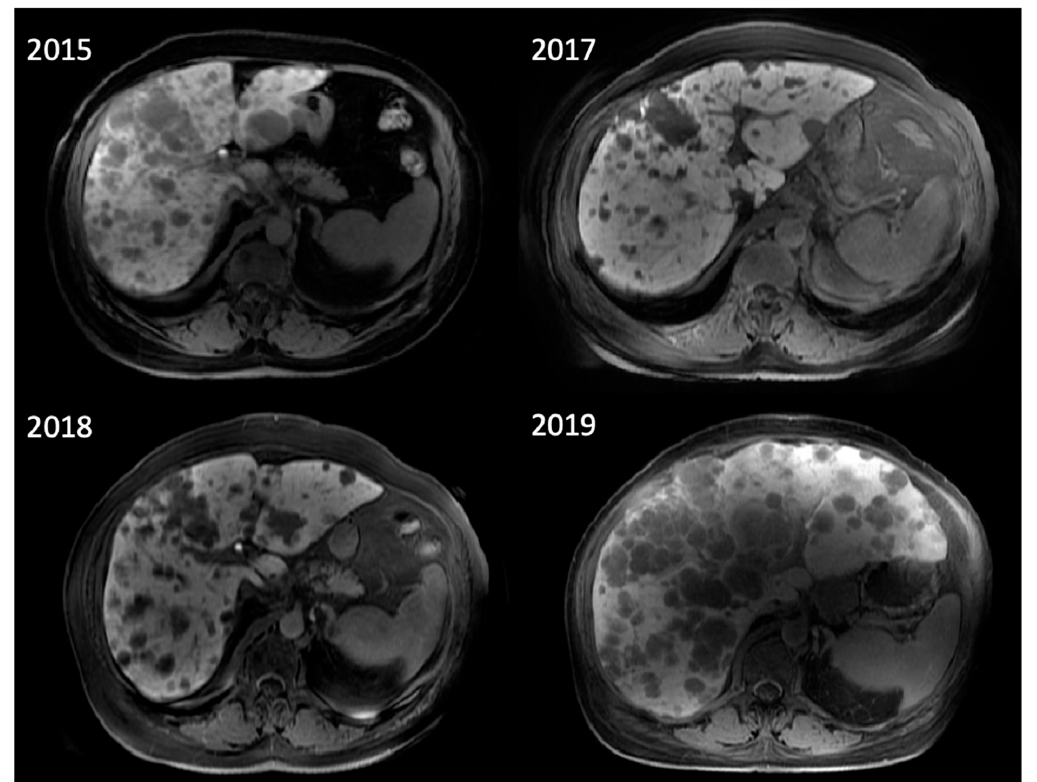
Figure 2. A 69-year-old woman with uveal melanoma metastatic to the liver post-treatment with tebentafusp, a bispecific antibody (BsAb), who developed cytokine release syndrome without radiologic imaging manifestations. Her large-burden liver disease was largely stable over the course of almost 3 years.